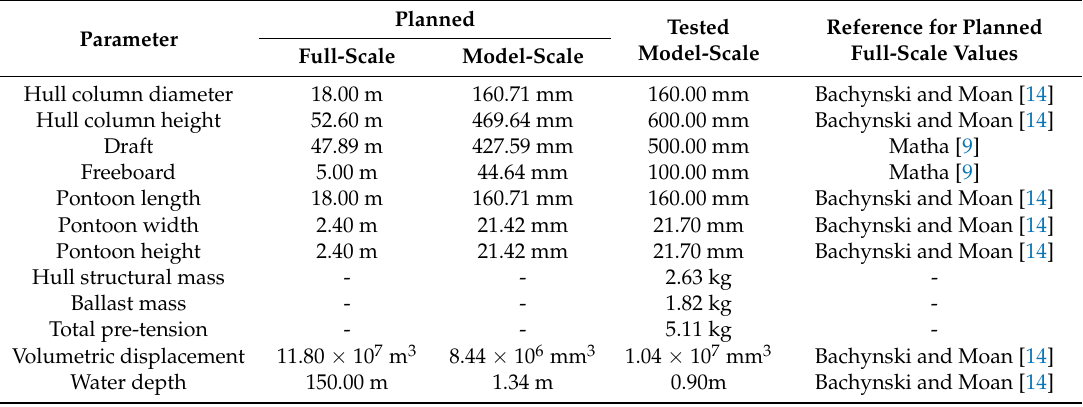
Table 1. ‘As constructed’ parameters of TLP